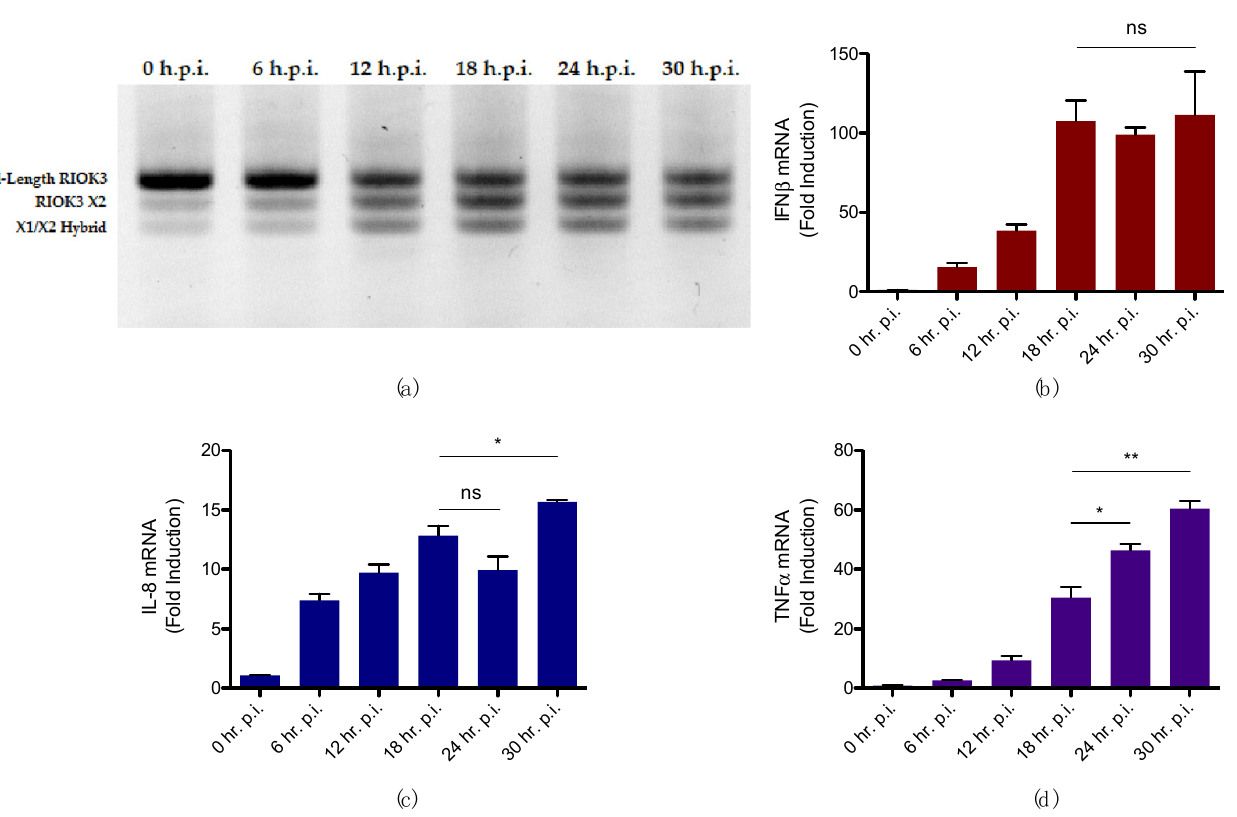
Figure 4. Accumulation of alternatively spliced RIOK3 mRNA isoforms during RVFV MP12 infec- tion correlates with a stalled IFN response but rising inflammatory response. ( a ) Alternative splicing of RIOK3 in RVFV MP12-infected HEK 293cells from 0 to 30 h.p.i. as detected by RT-PCR ( b ) IFN β mRNA expression in RVFV MP12-infected cells from 0 to 30 h.p.i. ( c ) IL-8 mRNA expression in RVFV MP12-infected cells from 0 to 30 h.p.i. ( d ) TNF α mRNA expression in RVFV MP12-infected cells from 0 to 30 h.p.i. In plots ( b – d ), fold induction is relative to values of cells at 0 h.p.i. Cells were